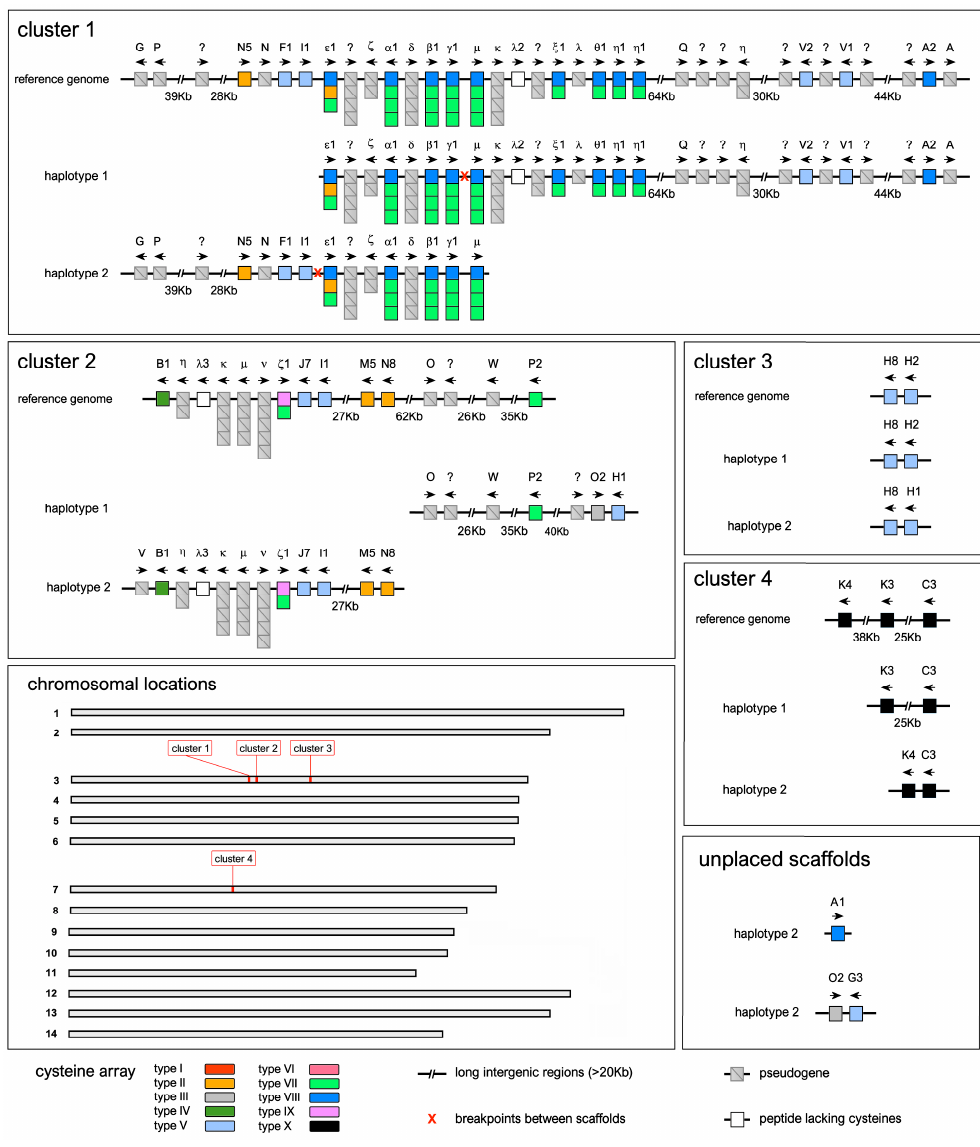
Figure 6. Organization and chromosomal location of the four CRP-I gene loci, with a detailed overview of the gene and pseudogene annotations present in the reference genome assembly, as well as in the two distinct phased haplotype assemblies. Each sCRP-I gene is indicated by a single box, whereas mCRP-I genes are indicated by multiple stacked boxes, representing, from the top to the bottom, N-terminal and C-terminal knottin arrays. Pseudogenes are marked by crossed-out grey boxes. Arrows indicate the coding strand of each gene (forward or